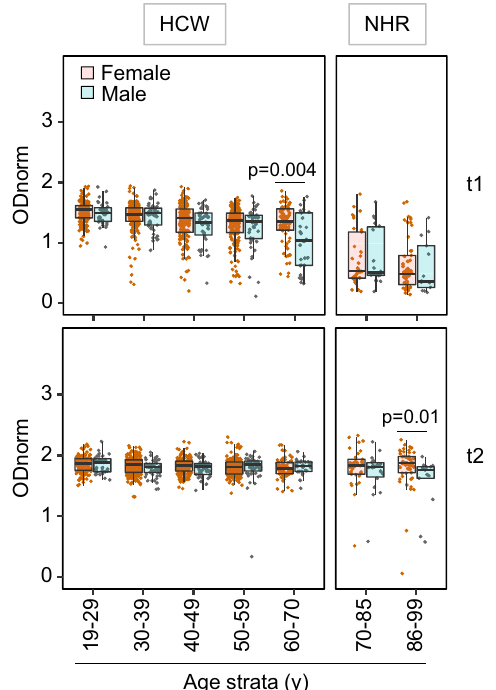
Fig. 4 Sex modulates vaccine-induced anti-SARS-CoV-2- spike